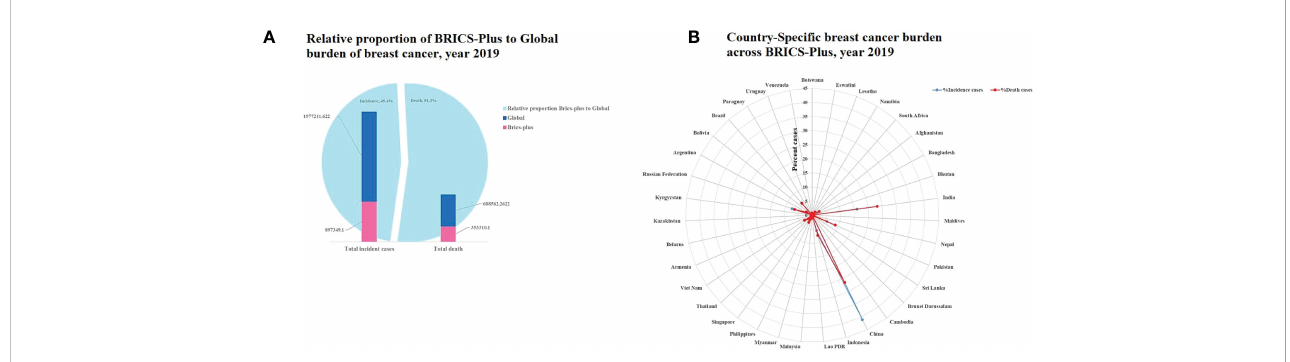
FIGURE 1 (A) Relative proportion of BRICS-Plus to Global burden of breast cancer incidence and death in year 2019, (B) Country speci fi c breast cancer burden within BRICS-Plus; percent cases (incidence and death) indicate proportion of country speci fi c cases to total cases in